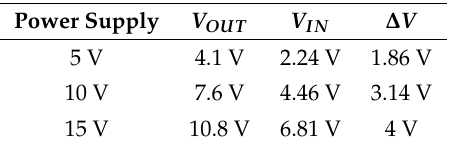
Figure 19. Dynamic analysis of the bias point of the LL-PFGA. The amplifier is turned on at t = 0 s. Table 5. Measurements of the bias point of the PFGA at steady